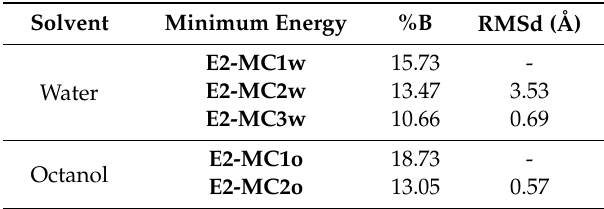
Table 3. %B and RMSd values of the most probable energy minima for E2, obtained after MC simulations conducted both solvents. RMSd values (Å) are calculated on the heavy atoms of E2 compared to the global energy minima ( E2-MC1w and E2-MC1o ).